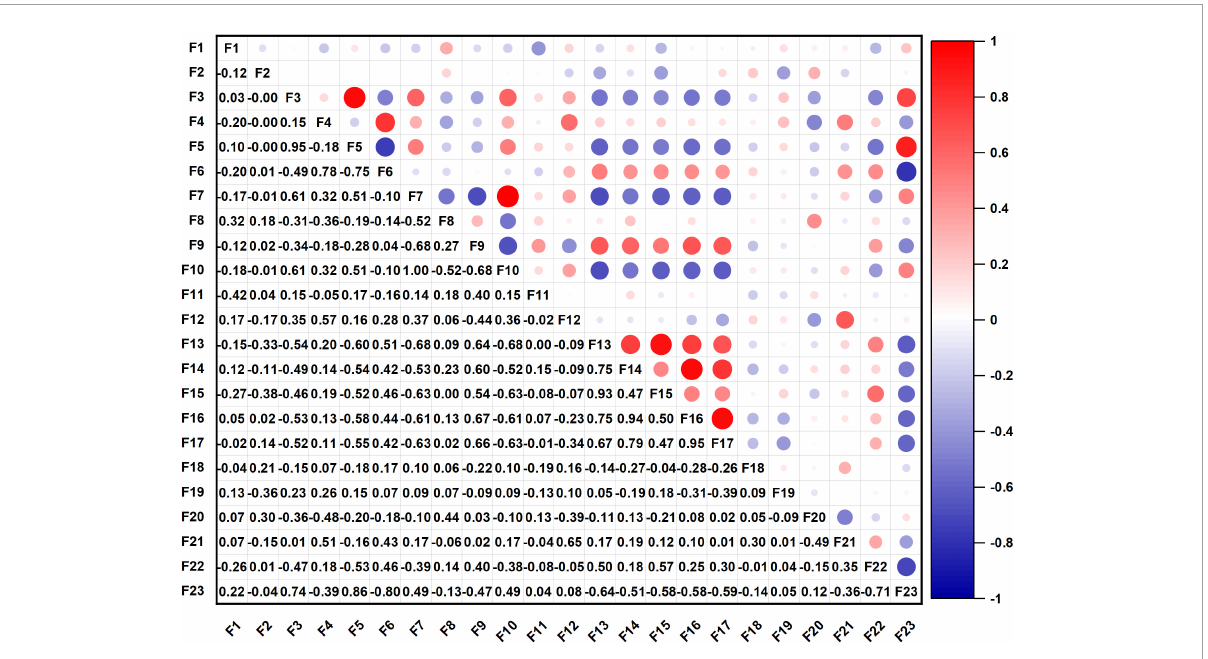
FIGURE1 Correlation coefficient heatmap of quality indexes (F1, moisture; F2, ash; F3, total starch; F4, amylose; F5, amylopectin; F6, ratio of amylose to amylopectin; F7, L; F8, a ∗ ; F9, b ∗ ; F10, (cid:49) E; F11, water absorption capacity; F12, oil absorption capacity; F13, peak viscosity; F14, trough viscosity; F15, breakdown; F16, final viscosity; F17, setback; F18, pasting temperature; F19, solubility; F20, swelling power; F21, rate of retrogradation; F22, gel strength; F23, sensory evaluation value).